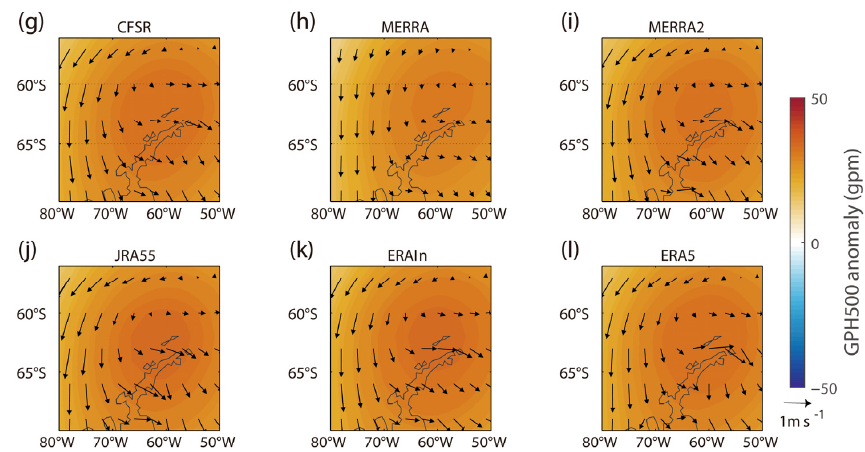
Figure 10. The combined maximum covariance analysis (CMCA) for Mode3 in the Antarctic Peninsula during austral autumn (MAM): ( a – f ) same as Figure 6, but for the Antarctic Peninsula region. The contour intervals are 0.25. The number at the top of each panel represents the temperature bias between the east and west Antarctic Peninsula; ( g – l ), the regression map of 500 hPa geopotential height (GPH500, color shading) and u, v component of 10 m wind (arrows).